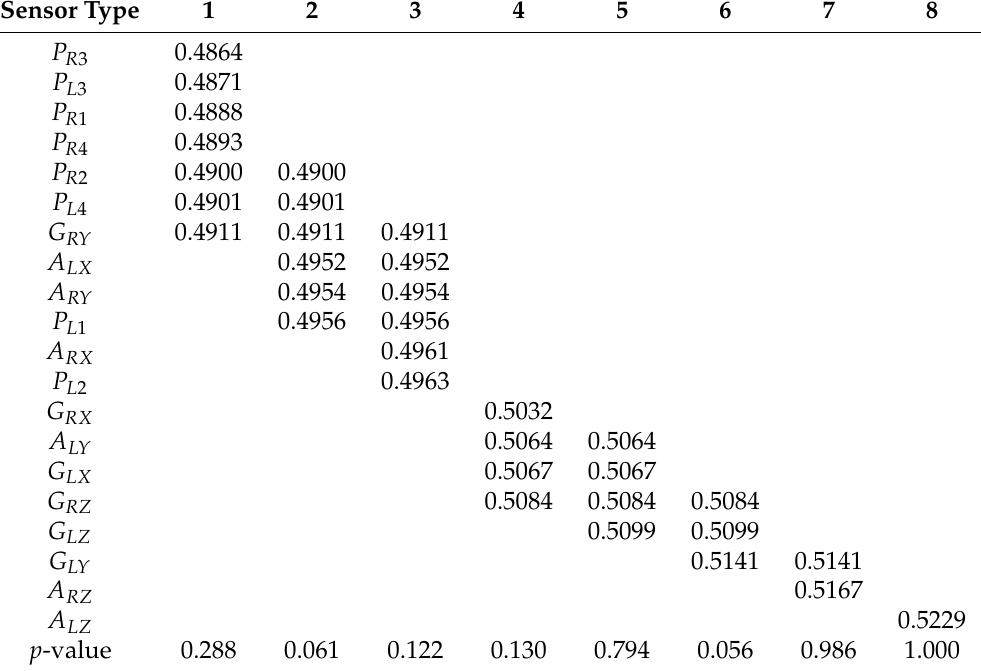
Table 9. Post-hoc Tukey HSD test result for the average attention weight for each sensor in HR estimation. Each column 1–8 represents a homogeneous subset for a significance level of